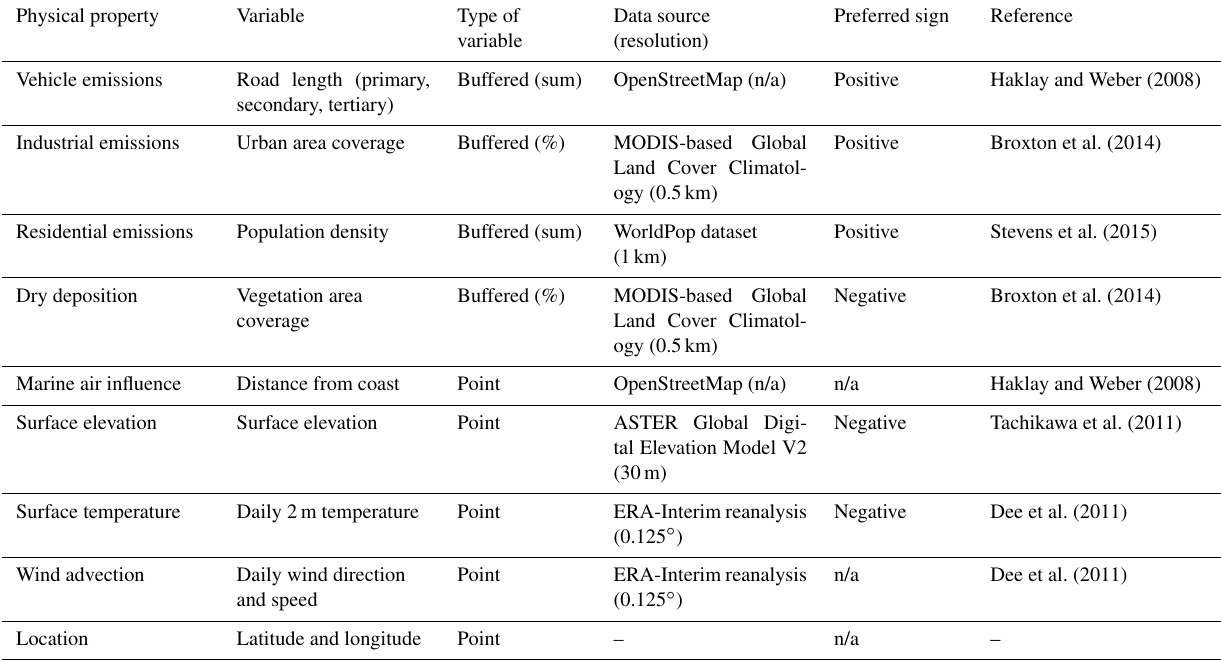
Table 1. The predictor variables ( X m ) considered for the LUR model (Eq. 1) used in this work. Physical property